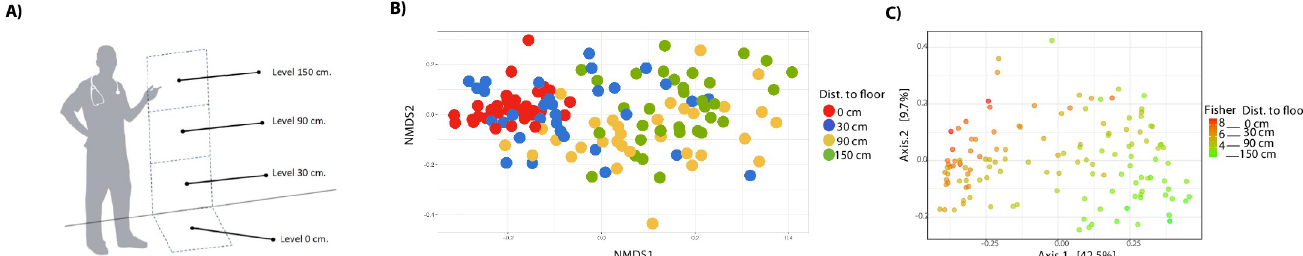
Fig 1. Detailed sampling diagram and beta diversity plots. Panel A is a diagrammatic description of the sampling panels at the OR done vertically. Panel B shows a non-metric multidimensional scaling (nMDS) plot, where points represent bacterial communities in samples of the OR, where walls are colored according to distance from the floor. Analysis of similarity (ANOSIM) on Bray-Curtis dissimilarity distance, showed a significant clustering (R = 0.04; P = 0.001). The statistical test for multivariate dispersions shows significant differences between communities at 0 cm, compared to all other wall heights ( P = 0.001). Panel C shows a PCoA plot where samples are colored according to Fisher’s alpha diversity, with alpha diversity being higher among floor (0 cm) samples and lower among those at higher height (150 cm).